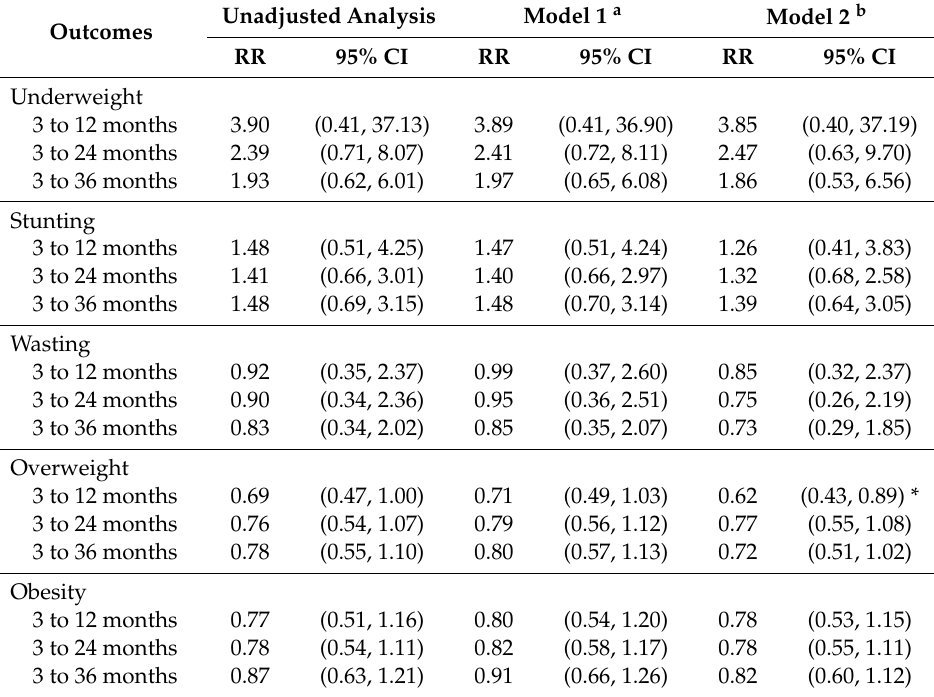
Table 5. E ff ects of maternal prenatal multi-micronutrient supplementation compared with iron and folic acid supplementation on infant linear growth within di ff erent age